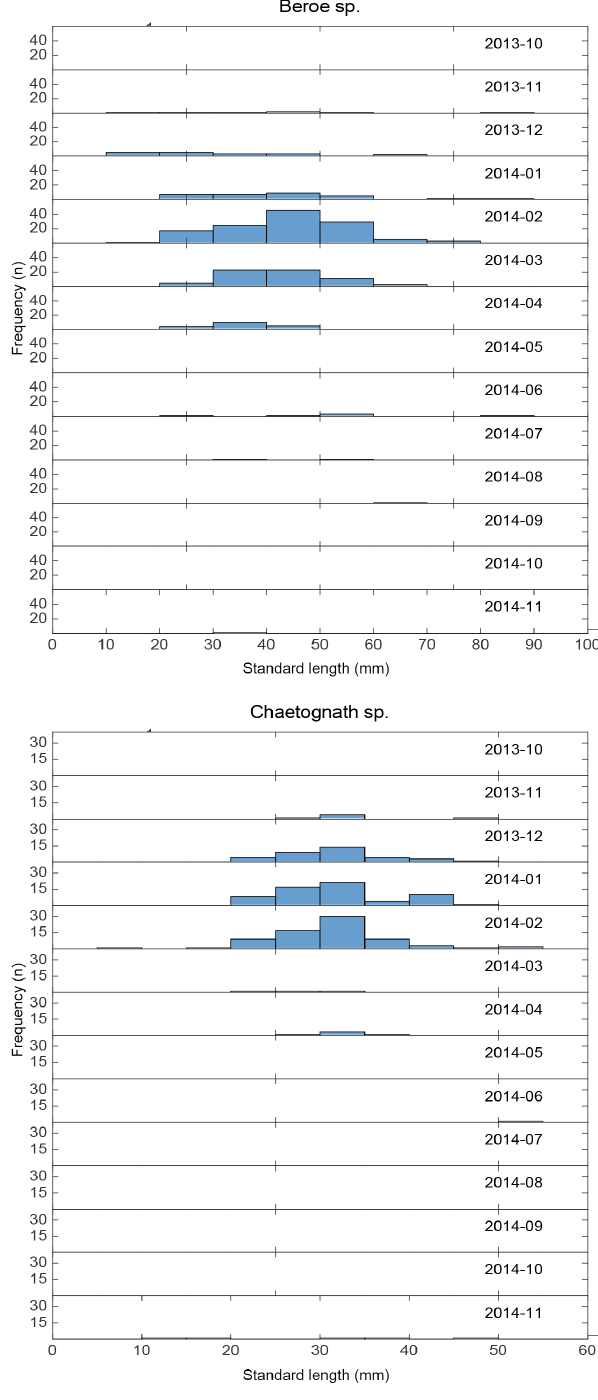
Figure 8. Length–frequency distributions of selected species or species groups (see panels) over the seasonal cycle.